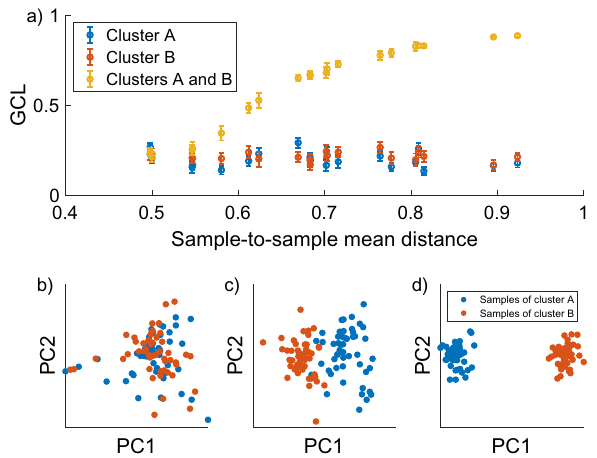
Figure 3. The effect of data heterogeneity on the GCL measure in simulated gene expression data. ( a ) The GCL as a function of the sample-to-sample mean distances between two simulated cohorts A and B . The GCL is calculated separately for cohort A , cohort B and the joint cohort A and B (blue red and yellow colors respectively). The dots represent the mean value of the GCL and the error bars represent the standard deviation of the 20 jackknife realizations. The differences between the GRN are controlled by the parameter 0 < p < 0.2 (see “Material and methods” ). As p increases, the sample-to-sample mean distances, D , increases as well. While the value of the GCL of each individual cohort remains stable, the value of the combined cohort increases to 1 due to the artificial heterogeneity in the data. ( b – d ) PCA visualizations of the two cohorts for three different 0.50063, 0.54042, 0.8583 respectively). The increased separation is visibly 0, 0.04, 0.2 with D values of D ( p = = 0.5 and the clusters of the cohorts are not 0 , D apparent. Note that for p ≈ =